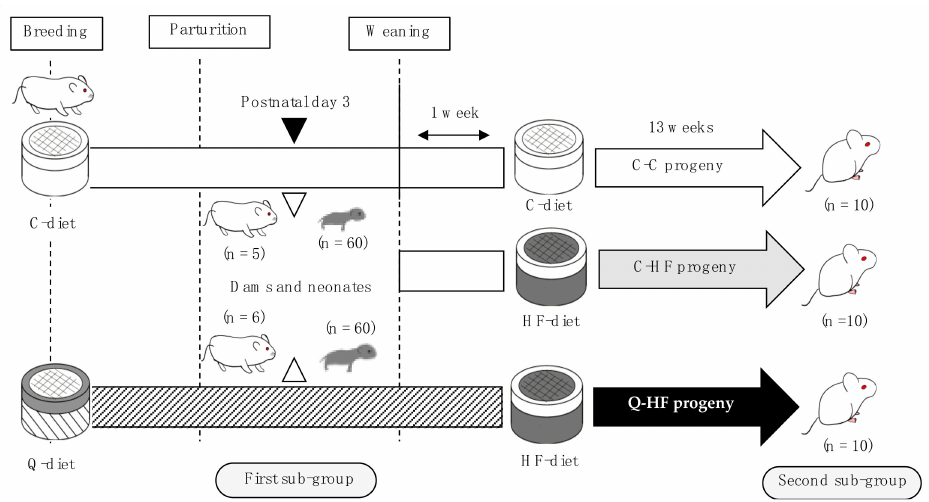
Figure 1. Schematic of the experimental design. After acclimatization on the control diet (C-diet), the quercetin groups were switched to a diet containing 1.0% quercetin (Q-diet). Breeding was carried out after 3 days on the Q-diet. The C-diet dams and their neonates, as well as the Q-diet dams and their neonates, were sacrificed on postnatal day 3 (first sub-group). Furthermore, 20 male progeny born to C-diet dams and 10 male progeny born to Q-diet dams were divided into three groups: male progeny of dams fed the C-diet that were also fed the C-diet (C-C), progeny of dams fed the C-diet that were fed a 30% high-fat (HF) diet (C-HF), and progeny of dams fed Q-diet that were fed a HF-diet (Q-HF). The animals were permitted free access C-diet or HF-diet for 13